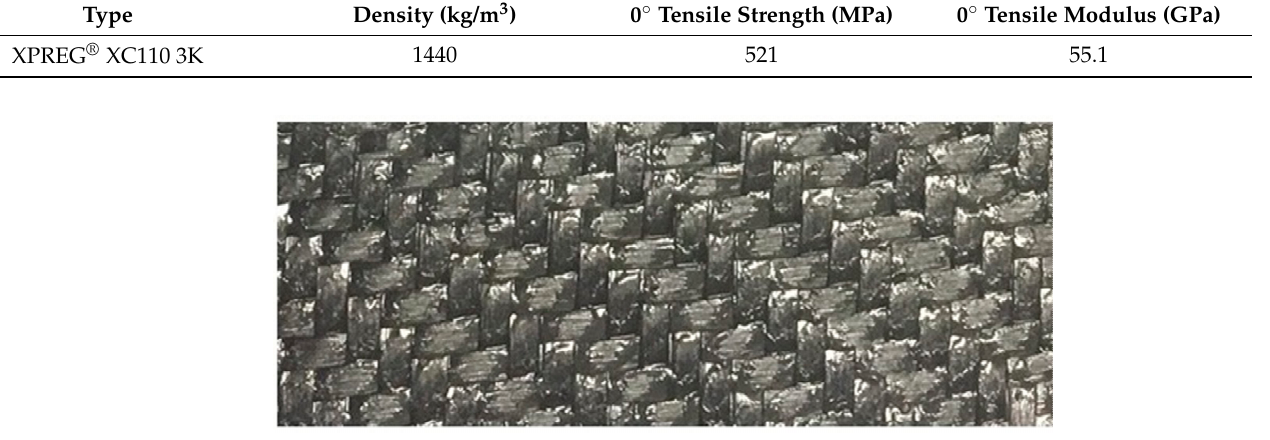
Figure 9. The weave style of fibre for XPREG ® XC110 epoxy system. The prepreg carbon fibre was cut to the right size and laminated on the aluminium skins at the two sides of the AFSS panel. The out-of-autoclave was chosen to cure